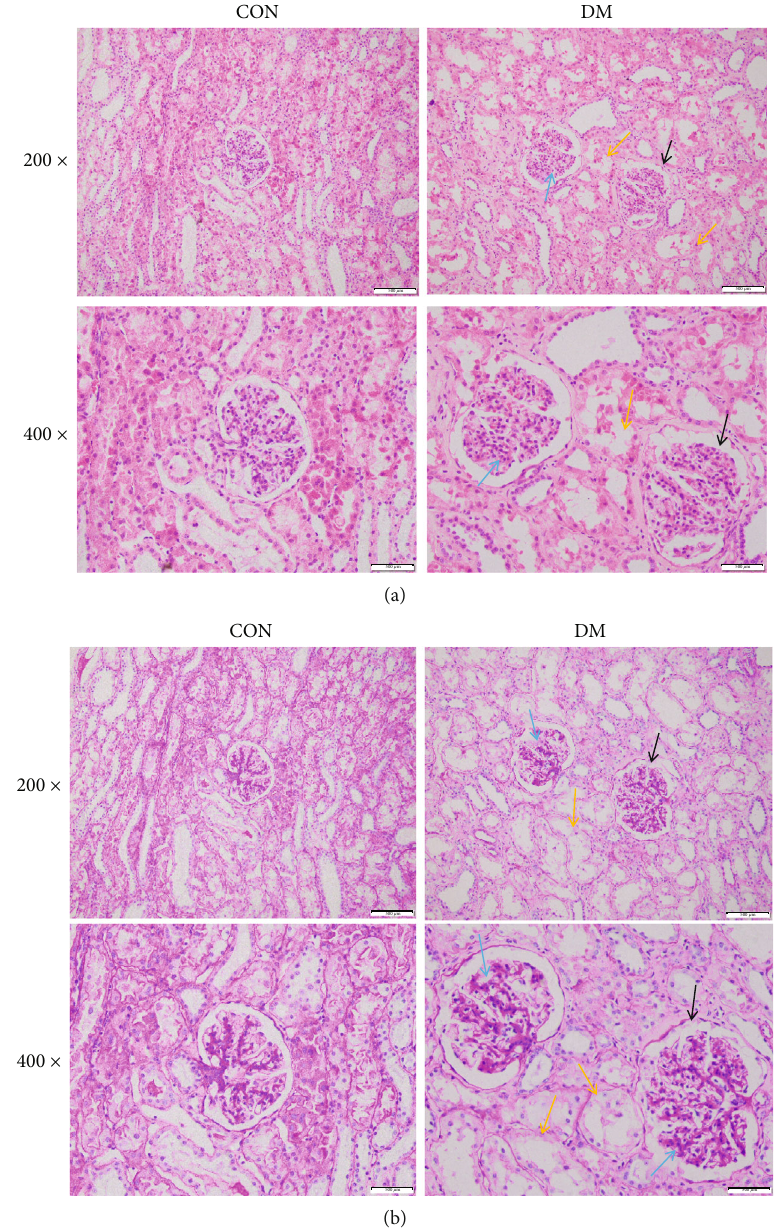
Figure 1: Optical microscope results of the kidneys of minipigs (magni fi cation: 200 × and 400 × ). (a) H&E staining results of the kidneys of minipigs. (b) PAS staining results of the kidneys of minipigs (black arrows: glomerular hypertrophy; blue arrows: increased mesangial matrix; yellow arrows: increased renal tubule (Figure 5), indicating that the TGF- β /Smad signaling pathway was activated during the development of diabetic kidney lesions.